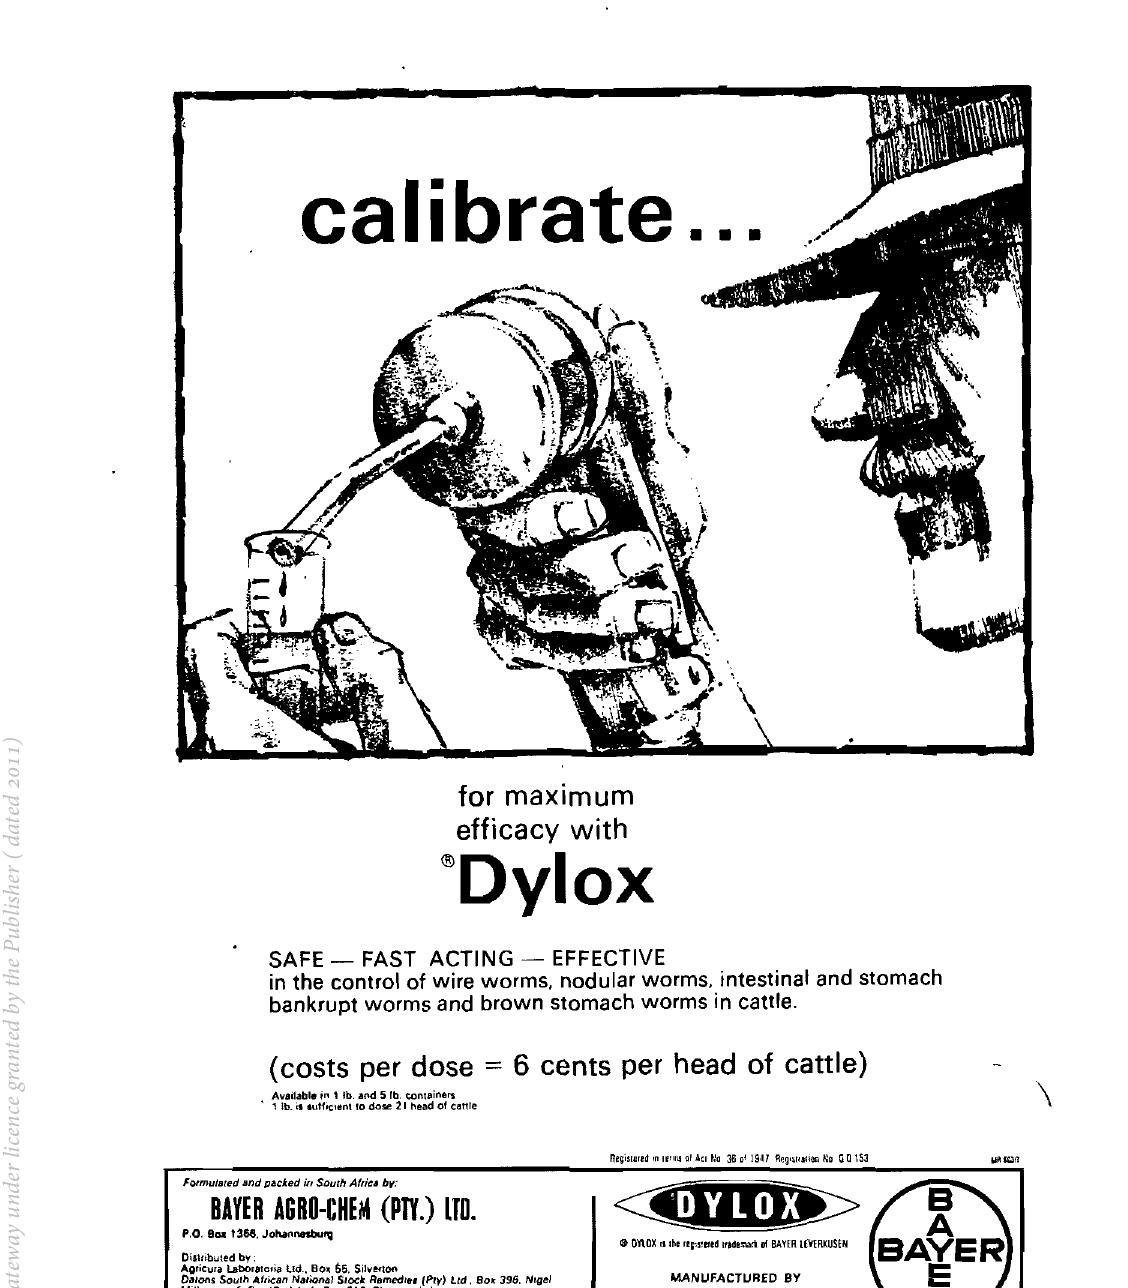
for maximum efficacy with ®Dylox SAFE - FAST ACTING - EFFECTIVE in the control of wire worms, nodular worms, intestinal and stomach bankrupt worms and brown stomach worms in